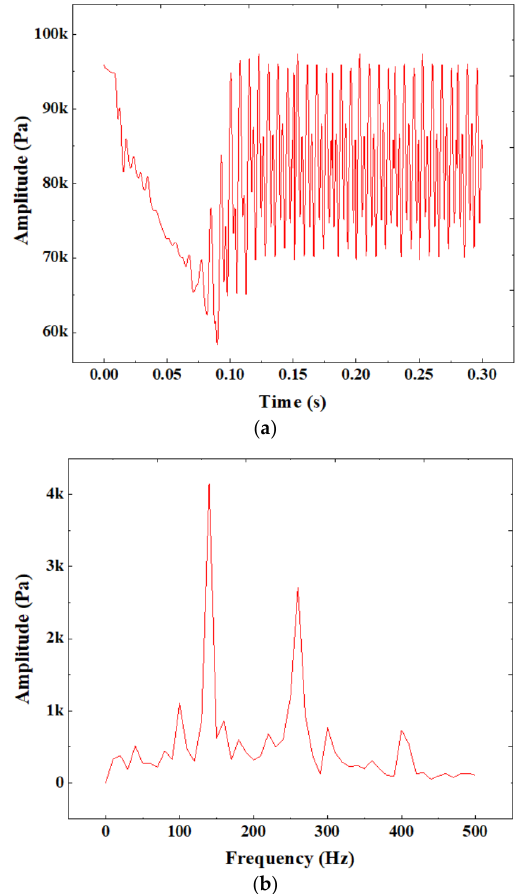
Figure 9. Results of CFD simulation under the condition of 200 MW. ( a ) Amplitude of pressure vs. flow time; ( b ) spectrum of dynamic pressure.